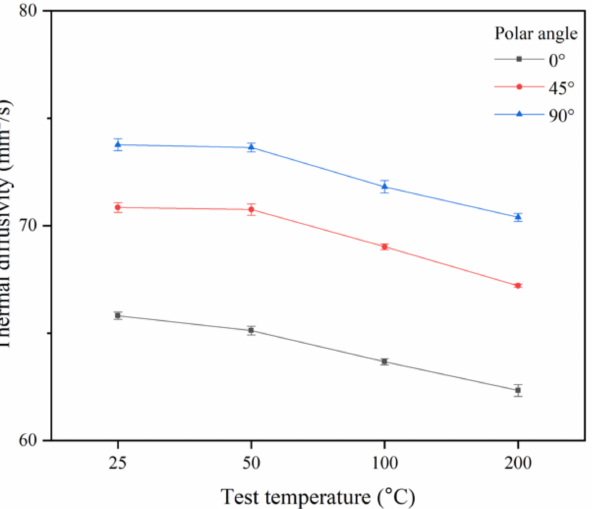
Figure 5. Thermal diffusivity for case 2 as a function of the polar angle at test temperatures of 25, 50, 100, and 200 ◦